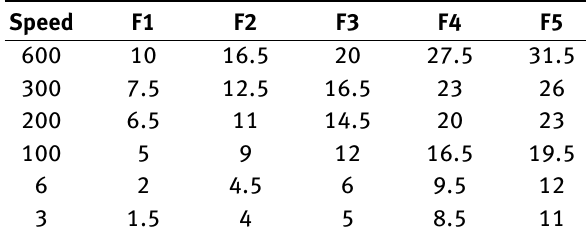
Table 2: Viscometer readings of each of the fluid